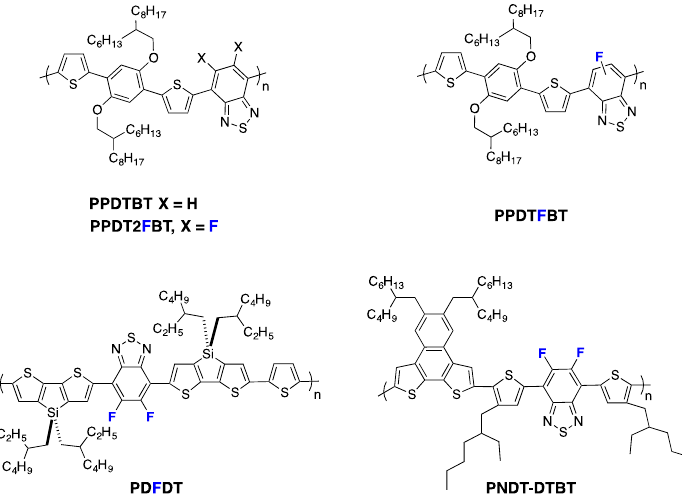
Figure 10. Chemical structures of some fluorinated polymers.